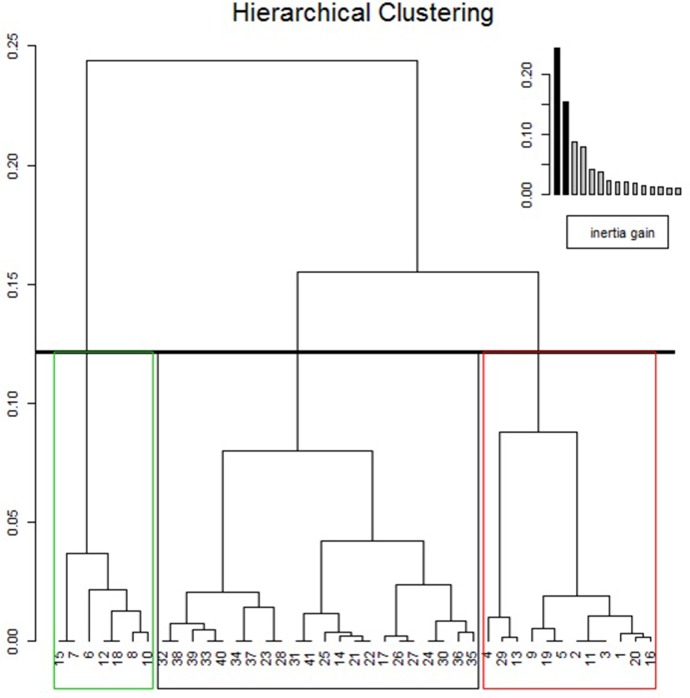
Hierarchical clustering on the first 5 dimensions of the multiple component analysis performed on data of the 41 males with complete data.